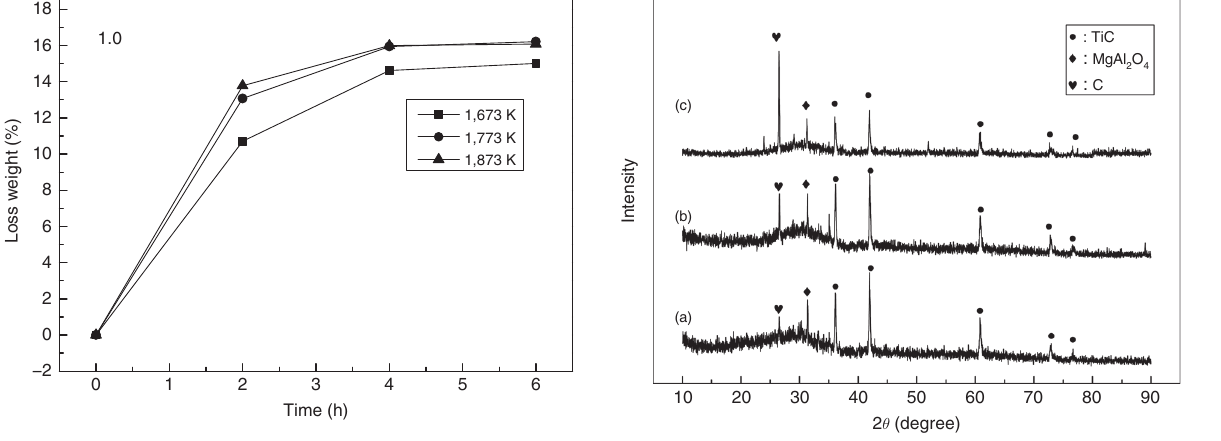
Figure 10: XRD results of reduced samples at 1,673 K, 2 h for different carbon ratios: (a) 0.7, (b) 0.85 and (c) 1.0.